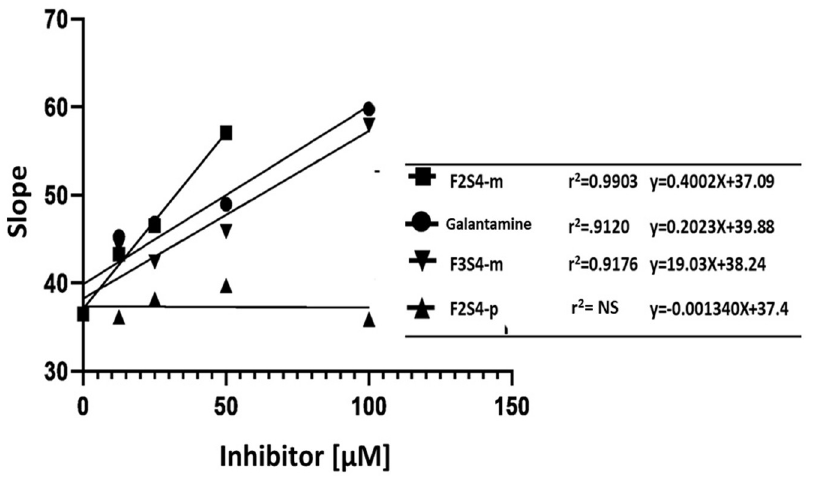
Fig 7. Determination of the inhibition constant (Ki) of compounds F2S4-m, F3S4-m, F2S4-p and galantamine by graphing the slope of lineaweaver-burk model against the respective inhibitor concentration.